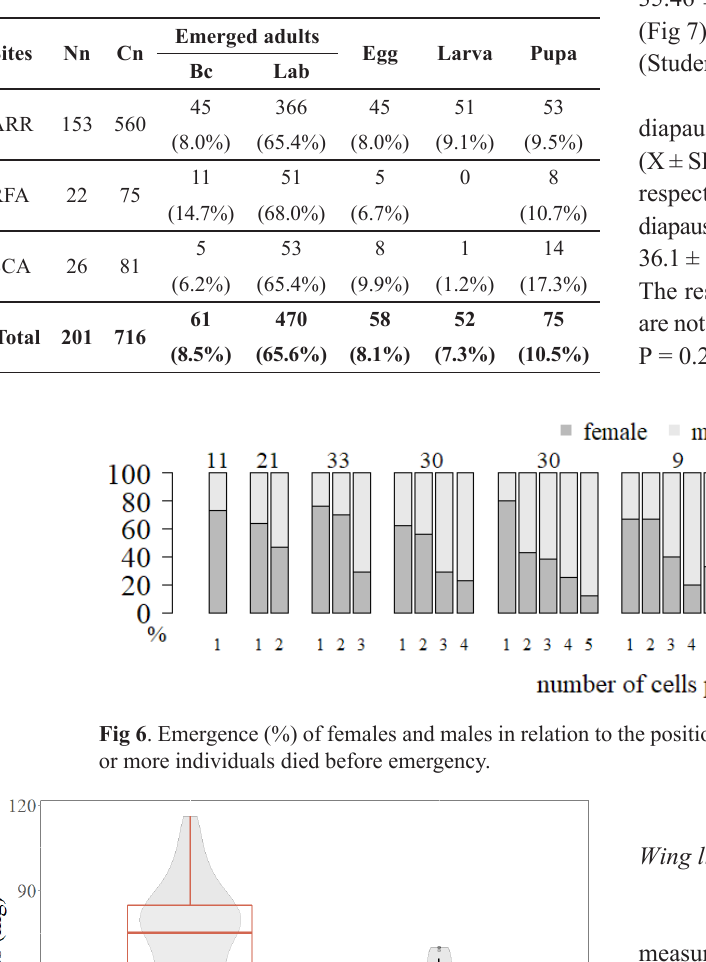
Table 3 . Number of nests (Nn) and cells (Cn), number and percentage of emerged adults before collection (Bc) or at the laboratory (Lab). Number of died individuals in egg, larva or pupa stage of P. denticulatum nests sampled in three study sites (ARR: Araras-SP, RFA: Rifaina-SP, SCA: São Carlos-SP).